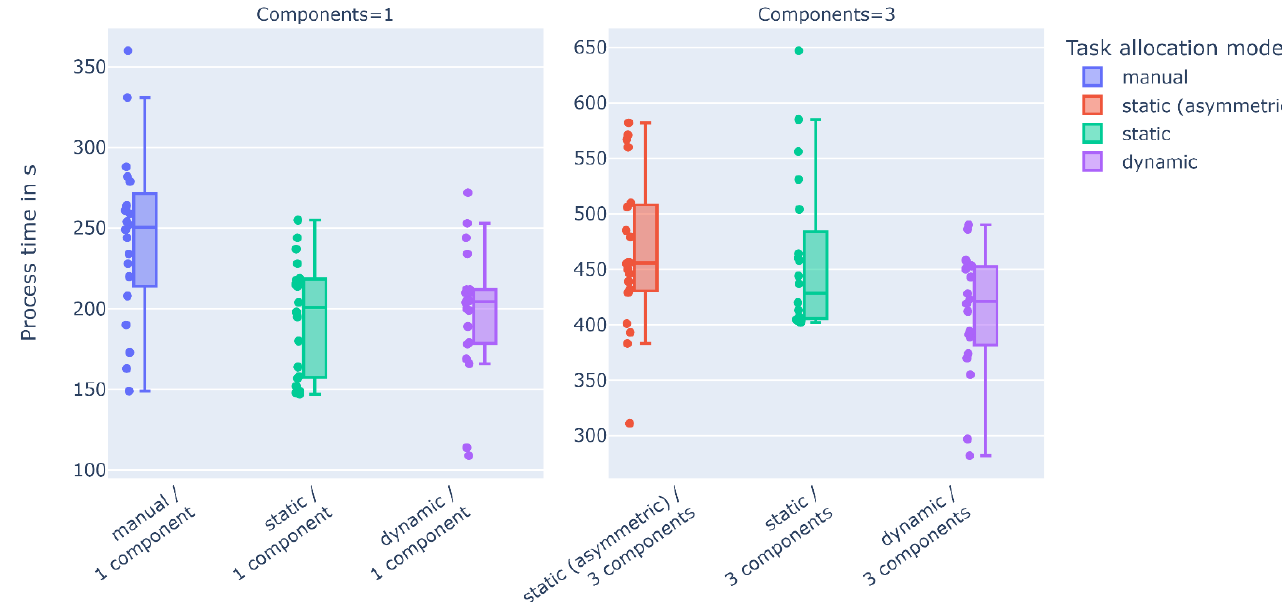
Figure 18. Comparison of task allocation modes depending on the number of assembled components.